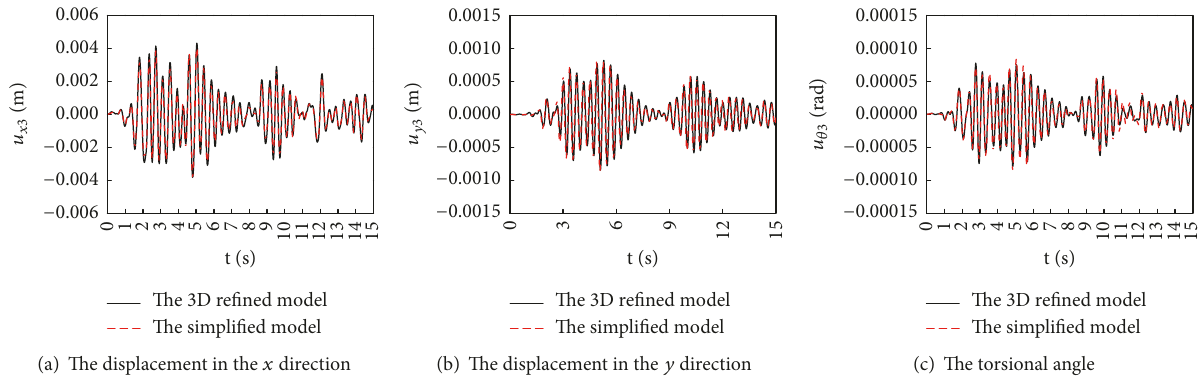
Figure 23: The top floor displacement curves at the center of mass under frequently occurred earthquake (EL-Centro wave).